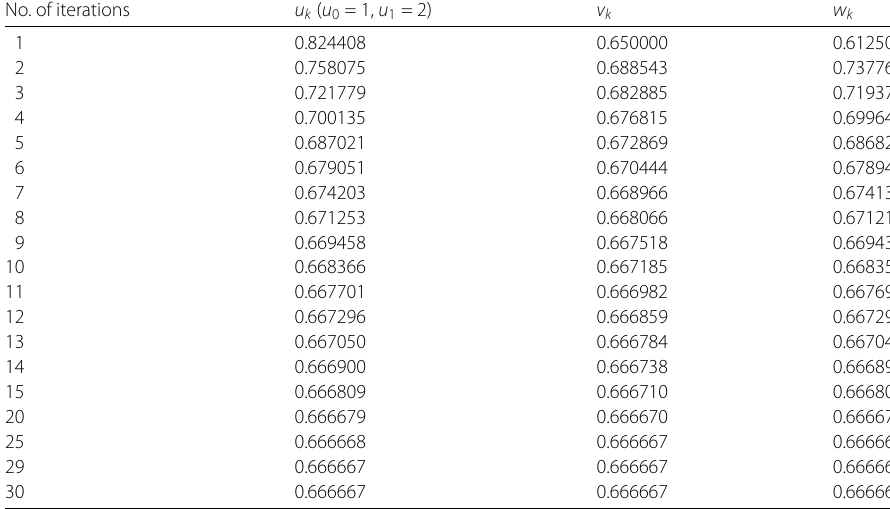
Table 1 Values of u k , v k and w